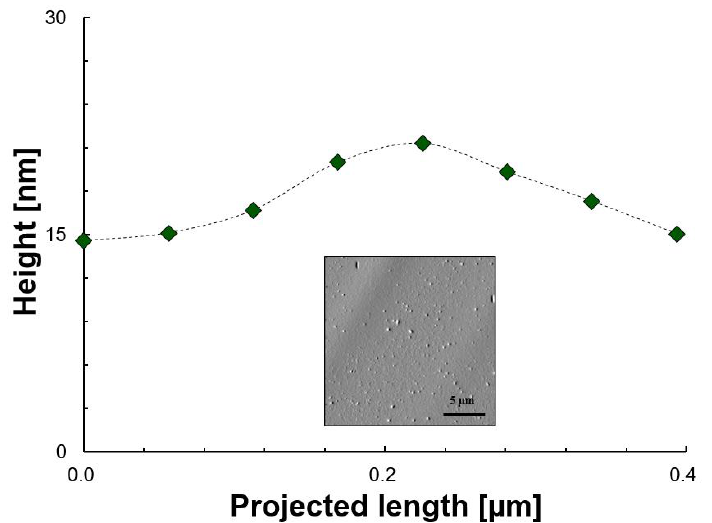
Figure 4. Height as a function of the projected length and morphology of aggregates/sediment of model 2 after n- heptane and toluene evaporation. The green icons are the experimental points, the dashed line is for illustrative purposes only and the image is to show the area where data was extracted.